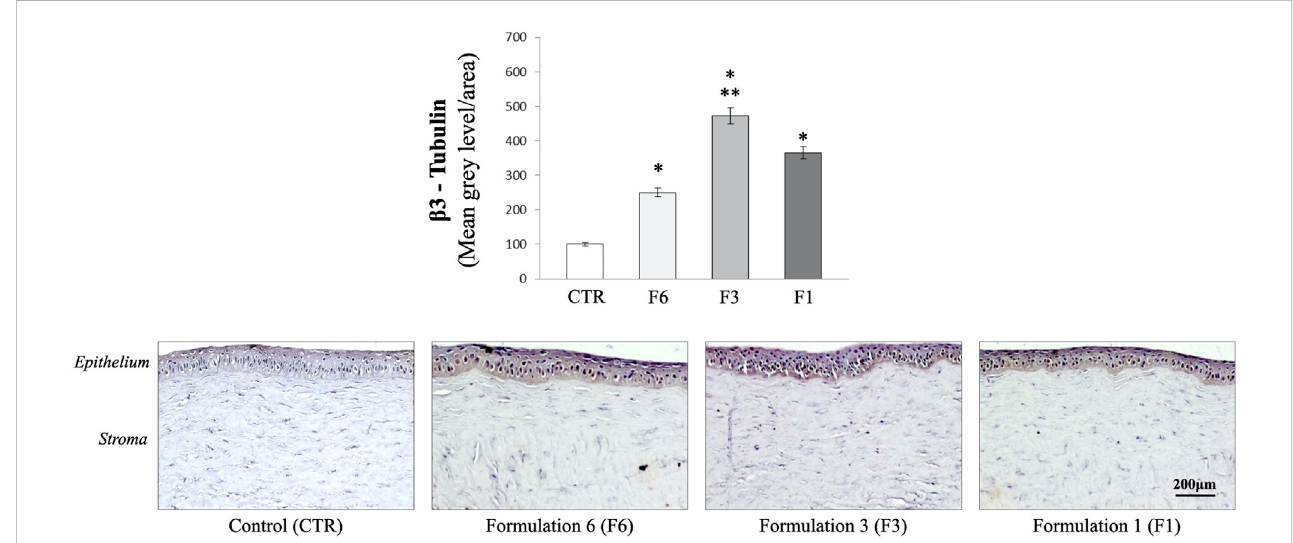
FIGURE 4 Immunohistochemical analysis. Measurement of corneal ß-III tubulin expression. Formulation 6 (F6); Formulation 3 (F3, RenerviX ® ); Formulation 1 (F1); Control group. * p < 0.01 vs. CTR; ** p < 0.01 vs. F6 and F1. Data are shown as mean ± SD ( n =